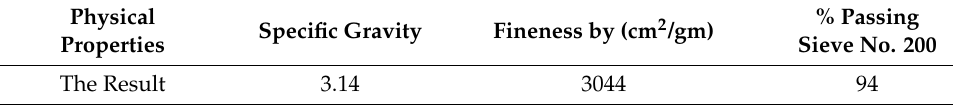
Table 8. The chemical properties of the ordinary filler.